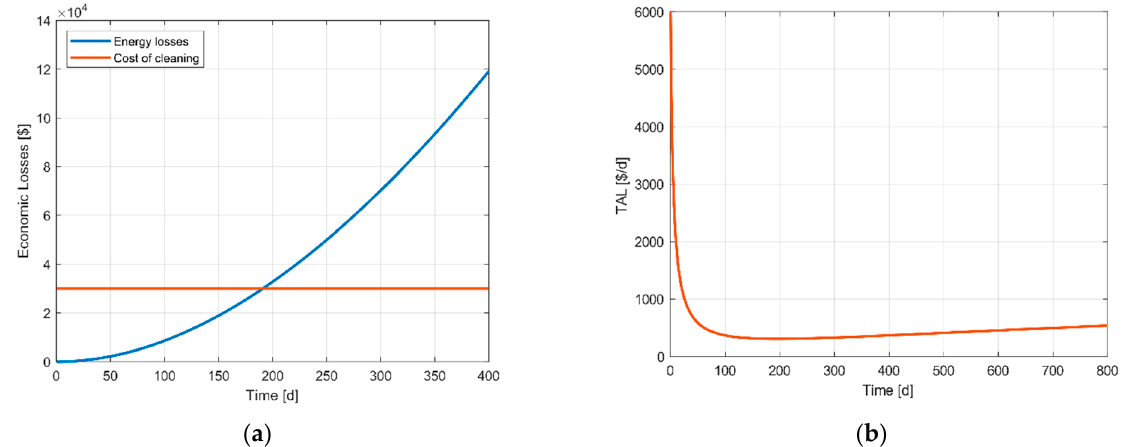
Figure 5. Mechanical cleaning: ( a ) Energy Losses and Cleaning Costs vs. cycle time; ( b ) Time Average Losses (TAL) vs. cycle